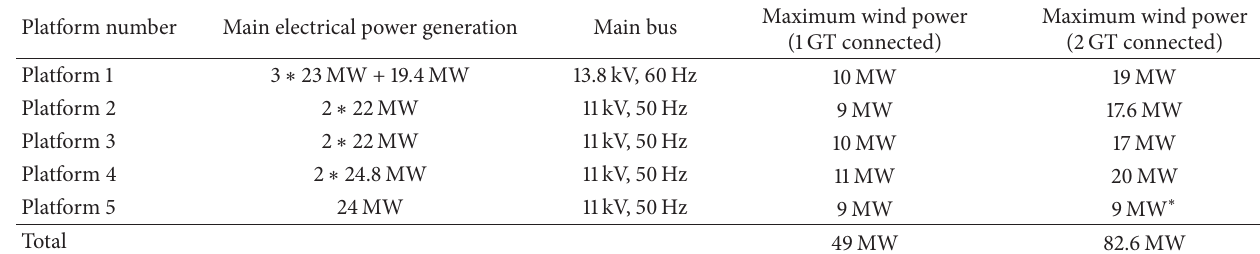
Table 5: Maximum wind power for integration to each platform individually.